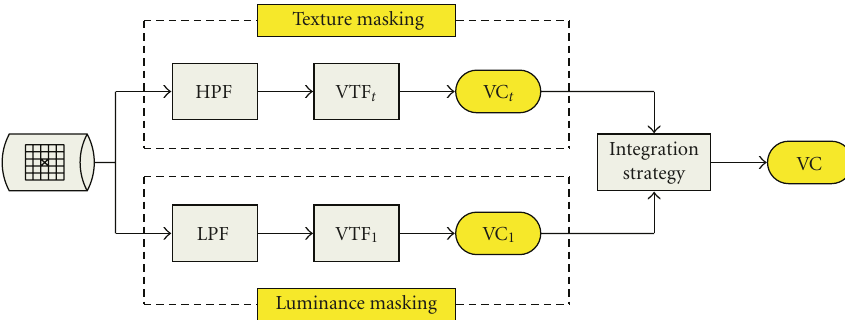
Figure 4: Schematic overview of the proposed human vision model.